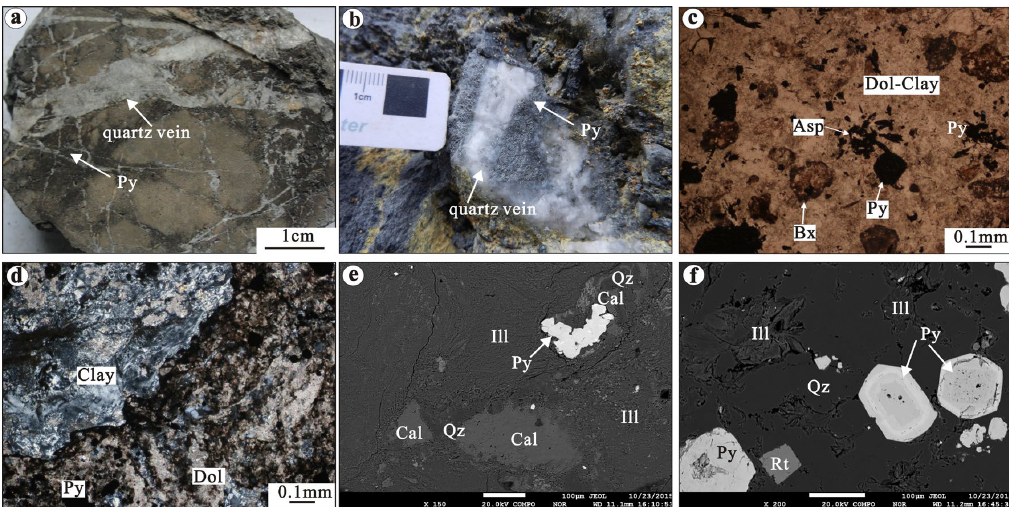
Figure 4. Macrocharacteristics and microscopic textures of various rocks in the Nibao gold deposit: ( a ) vein (stockwork) quartz and disseminated pyrite in sedimentary tu ff s; ( b ) vein quartz associated closely with pyrite in tu ff s; ( c ) pyrite showing subidiomorphic–idiomorphic granular texture and arsenopyrite showing subidiomorphic texture in sedimentary tu ff s (transmitted light, polarized light); ( d ) strong argillization and carbonatization in sedimentary tu ff s (transmitted light, crossed polarizers); ( e ) silicification, pyritization, carbonatization, and argillization in sedimentary tu ff s (BSE); ( f ) silicification, pyritization, and argillization in tu ff s (BSE). Mineral abbreviations: Py = pyrite, Asp = arsenopyrite, Dol = dolomite, Cal = calcite, Clay = clay, Bx = vitric tu ff , Rt = rutile, Qz = quartz, Ill =